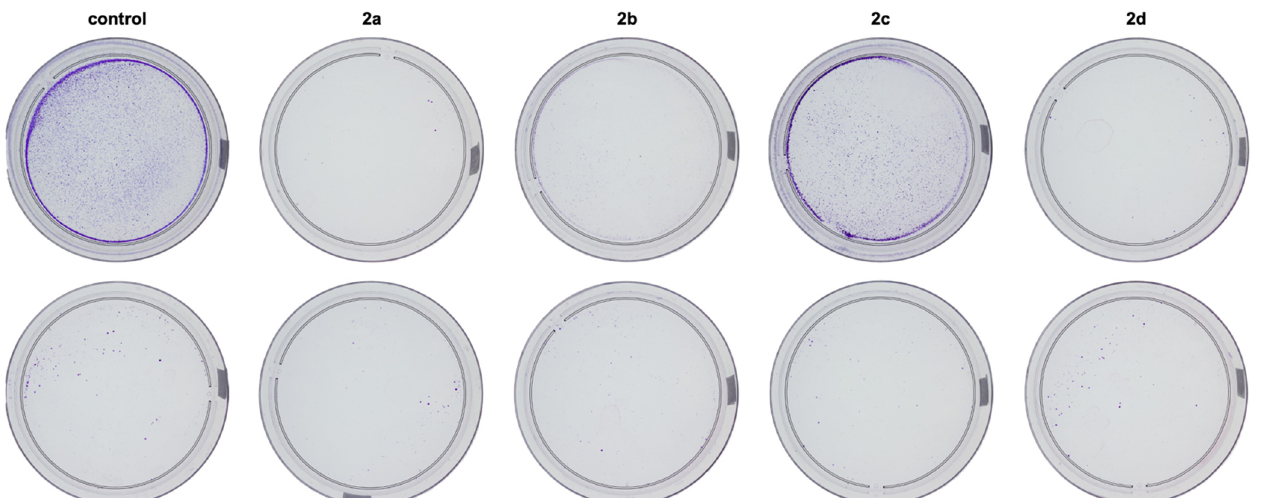
Table 1. The IC 50 values for 2a – 2d obtained for HUH7 and HepG2 cell lines as well as the impact of 2a–2d used at IC 50 on the colony forming ability (clonogenicity). Cytotoxicity IC 50 (µM) Clonogenicity (% of Ctrl) Compound HUH7 HepG2 HUH7 2a No cytotoxic properties up to 500 μ M 2DG No cytotoxic properties up to 500 μ M Cells were incubated with the tested compounds for 72 h; data are expressed as mean ( μ M) and SD, n = 3; IC 50 values were received based on Graph-Pad Prism software calculations. Clonogenicity: HUH7 and HepG2 cells were incubated with 2a – 2d for 72 h at their IC 50 ; data are expressed as mean (% of control cells treated as 100%) and SD, n = 3; Chi-square analysis was performed to evaluate the significance of differences between control and treated cells as well as between cell lines and used chemicals; statistical analysis for HUH7: p < 0.05: 2a vs. 2d , 2b vs. 2d ; p < 0.01: control vs. 2c , 2c vs. 2d ; p < 0.001: control vs. 2a , 2b and 2d ; for HepG2: p < 0.05: control vs. 2c ; 2a